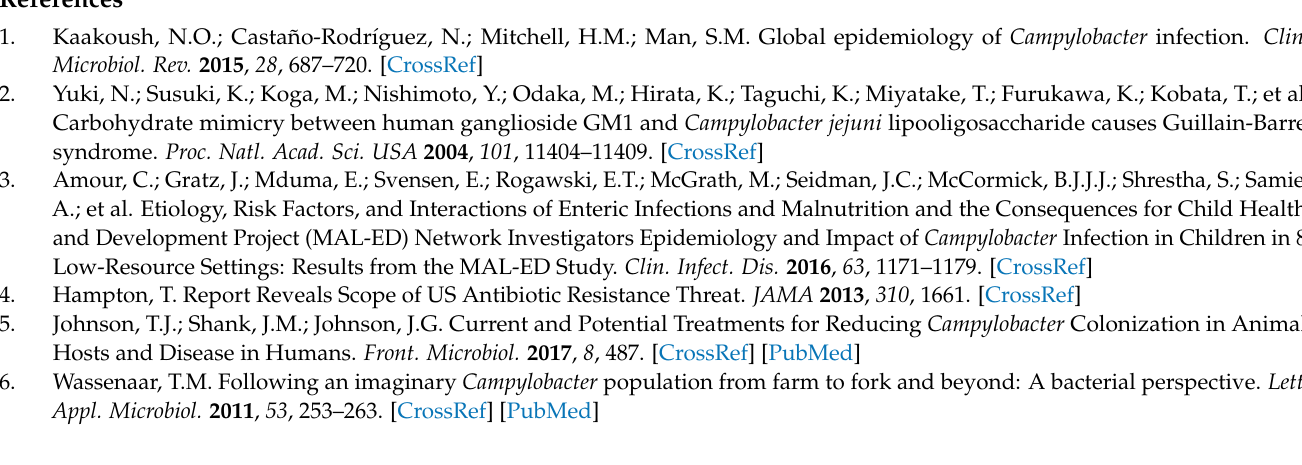
Table S2: Complete list of genetic polymorphisms and variant frequencies between NCTC 12673 phage (parent) and MutC, a spontaneous mutant phage isolated on C. jejuni 11168 ∆ pseC mutant